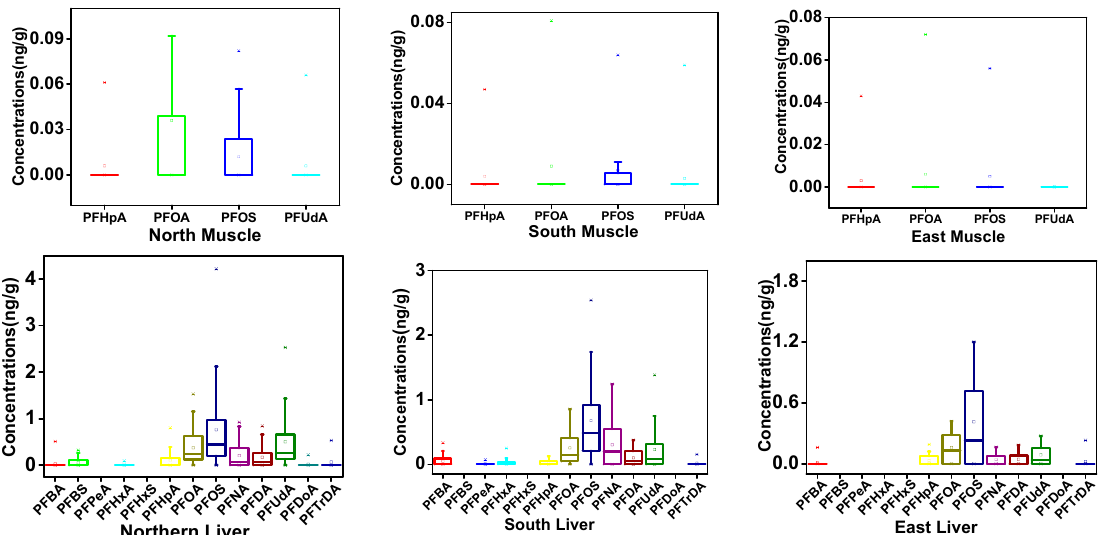
Figure 2. Box-and-whisker plots of detected PFAAs in muscle and liver from southern, northern and eastern Xinjiang (ng/g, wet weight). The horizontal line and the small square in the box respectively represent the mean and median value, and the 25th and 75th percentiles are marked by the lower and upper edges of the box. The whiskers extending from the box represent the highest and lowest values and the asterisks show extreme values.